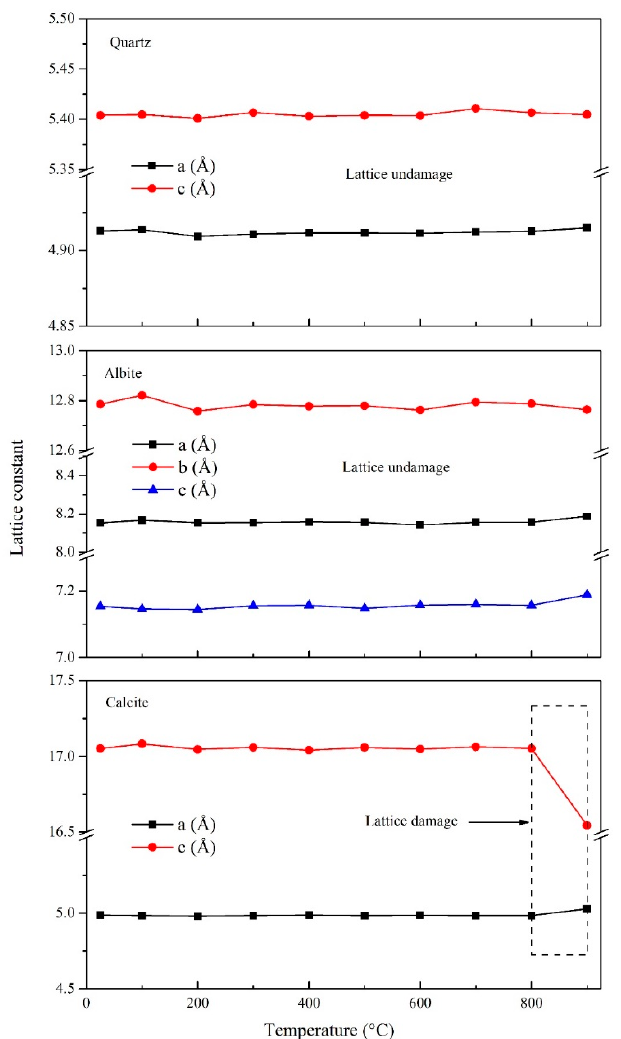
Figure 2. Changes of lattice constants of quartz, albite and calcite from 25 °C to 900 °C.